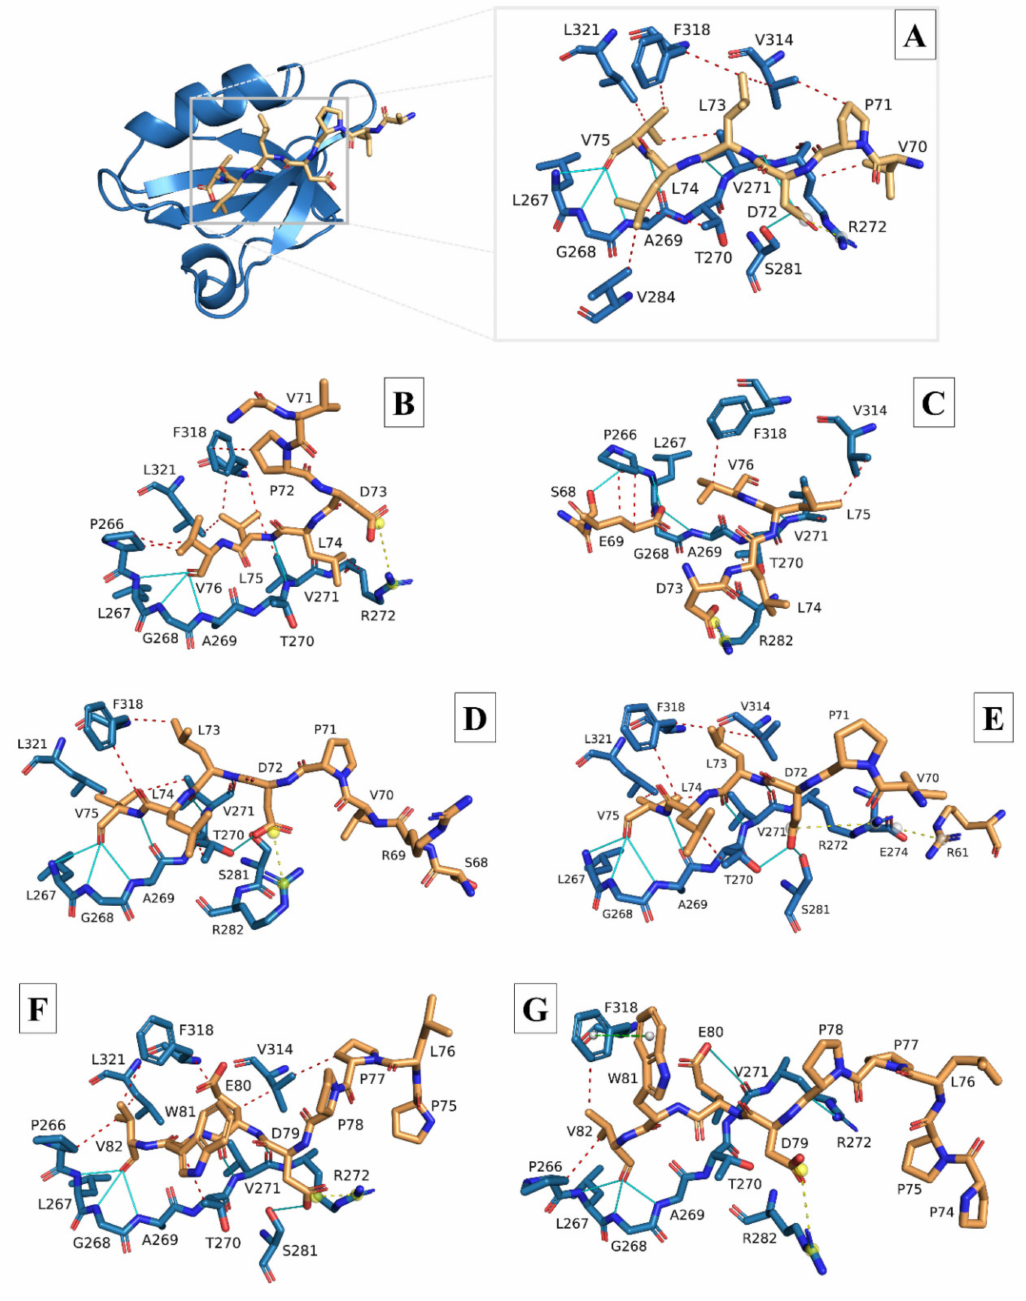
Figure 4. Stick models of the modelled 8-mer and 18-mer envelope (E) peptides of the more virulent hCoV E proteins docked to the PALS1 PDZ domain. ( A ) Ribbon and stick model of the SARS-CoV-2 experimental E peptide (stick, gold) docked to the PDZ domain of the PALS1 protein (ribbon